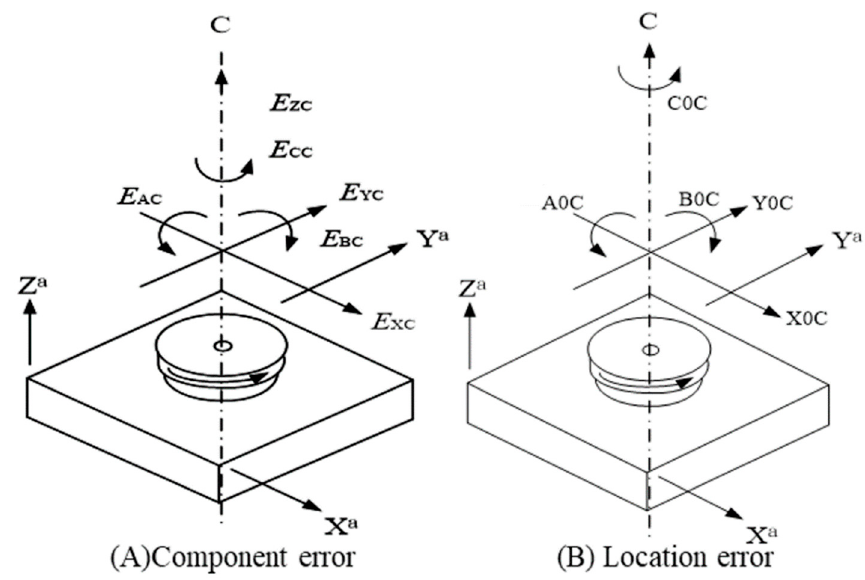
Figure 2. The ISO definition of rotary axis error schematic [20,21].